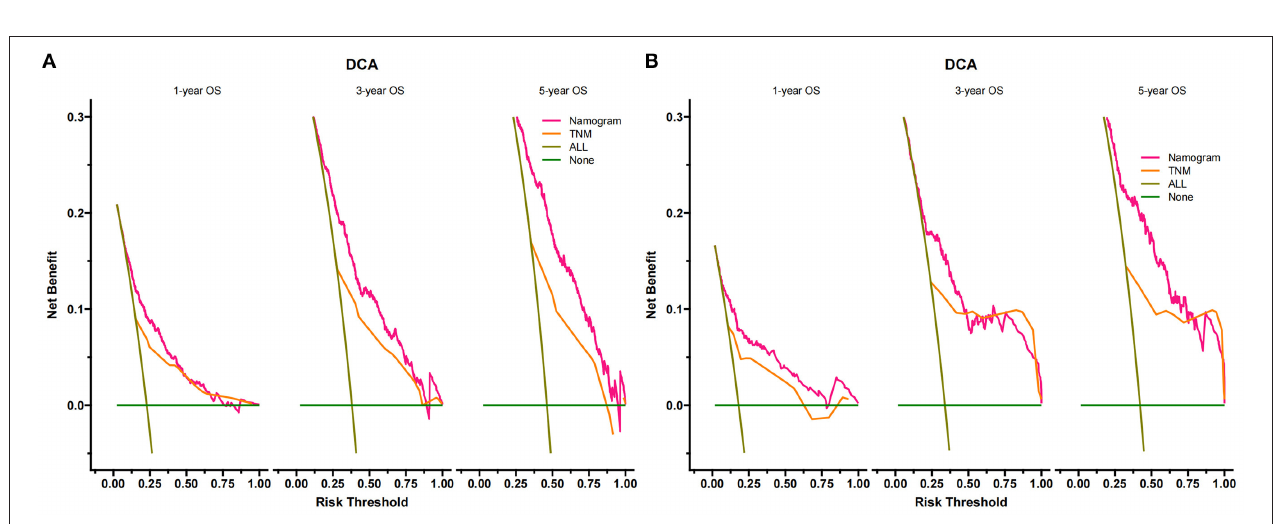
FIGURE 5 | Decision curves of the nomogram predicting OS in the training set (A) and validation set (B) . The y-axis represents the net benefit, and the x-axis represents the threshold probability. The green line indicates that no patients have died, and the dark green line indicates that all patients have died. When the threshold probability is between 20 and 100%, the net benefit of the model exceeds all deaths or no